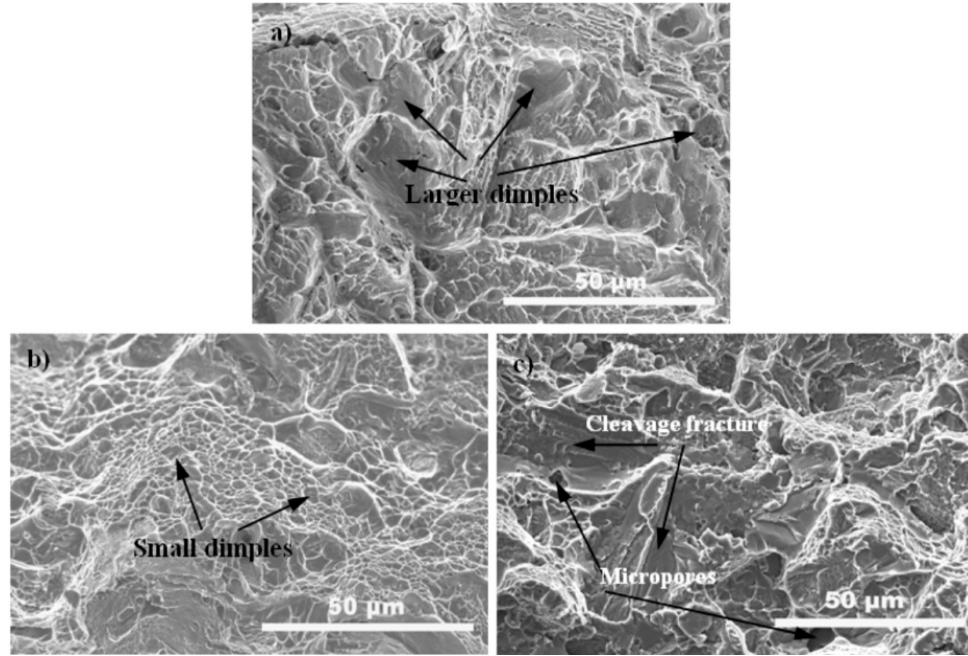
Figure 7. SEM images showing the tensile fracture surfaces of the monolithic TC4 sample ( a ), 0.27GO/TC4 composite ( b ), and 0.54GO/TC4 composite ( c ). 0.27GO/TC4 composite ( b ), and 0.54GO/TC4 composite ( c